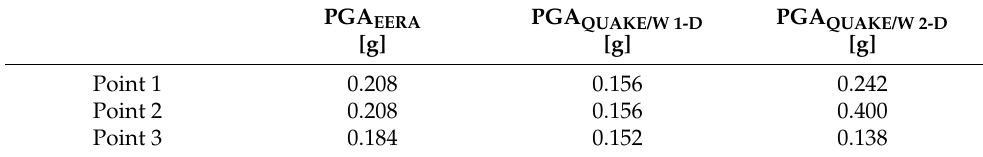
Table 8. PGA by 1-D and 2-D analyses for the Tortorici et al. [25], Bottari et al. [24], DISS Messina Strait, DISS Gioia Tauro, DISS Aspromonte Est, 1693 Catania earthquake inputs at point 1, 2 and 3.